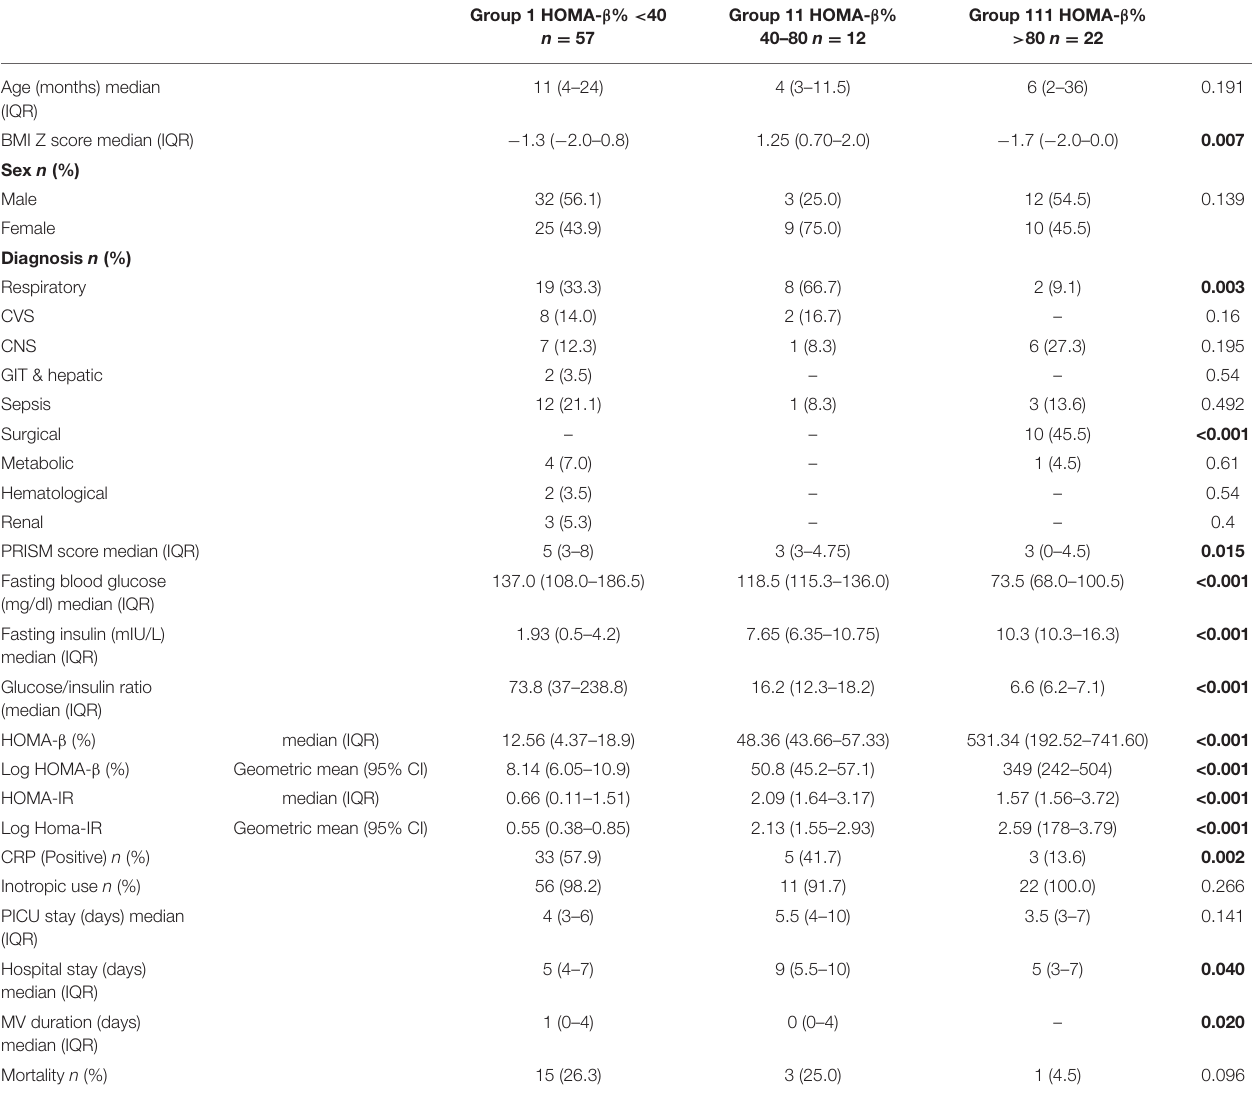
TABLE 1 | Clinical data, laboratory data, and outcome in the studied patients classified according to β -cell function ( N =